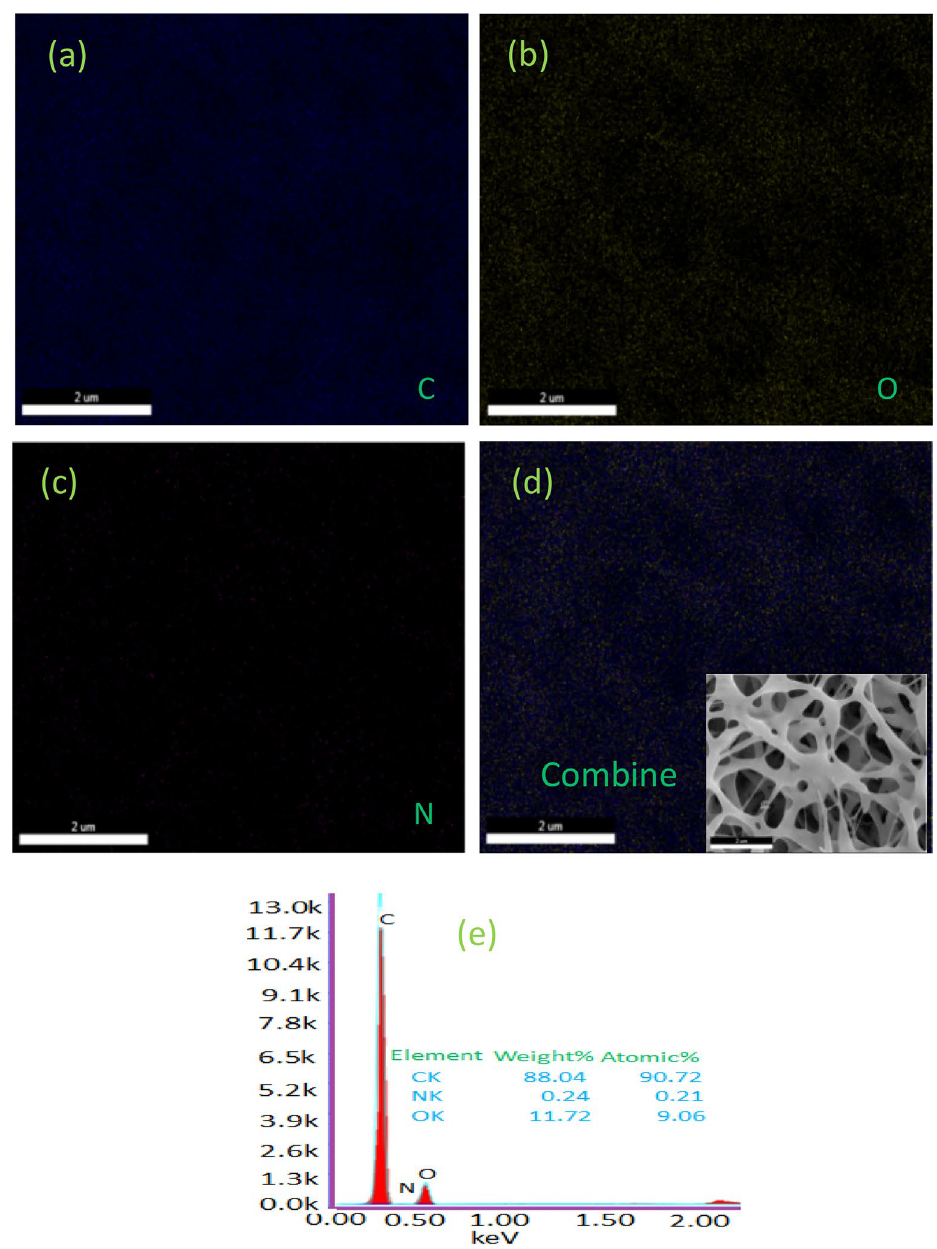
Figure 11. ( a – d ) Elemental mapping of PVA: CNPs: TLE after PM capture, ( e ) EDX of PVA: CNPs: TLE after PM